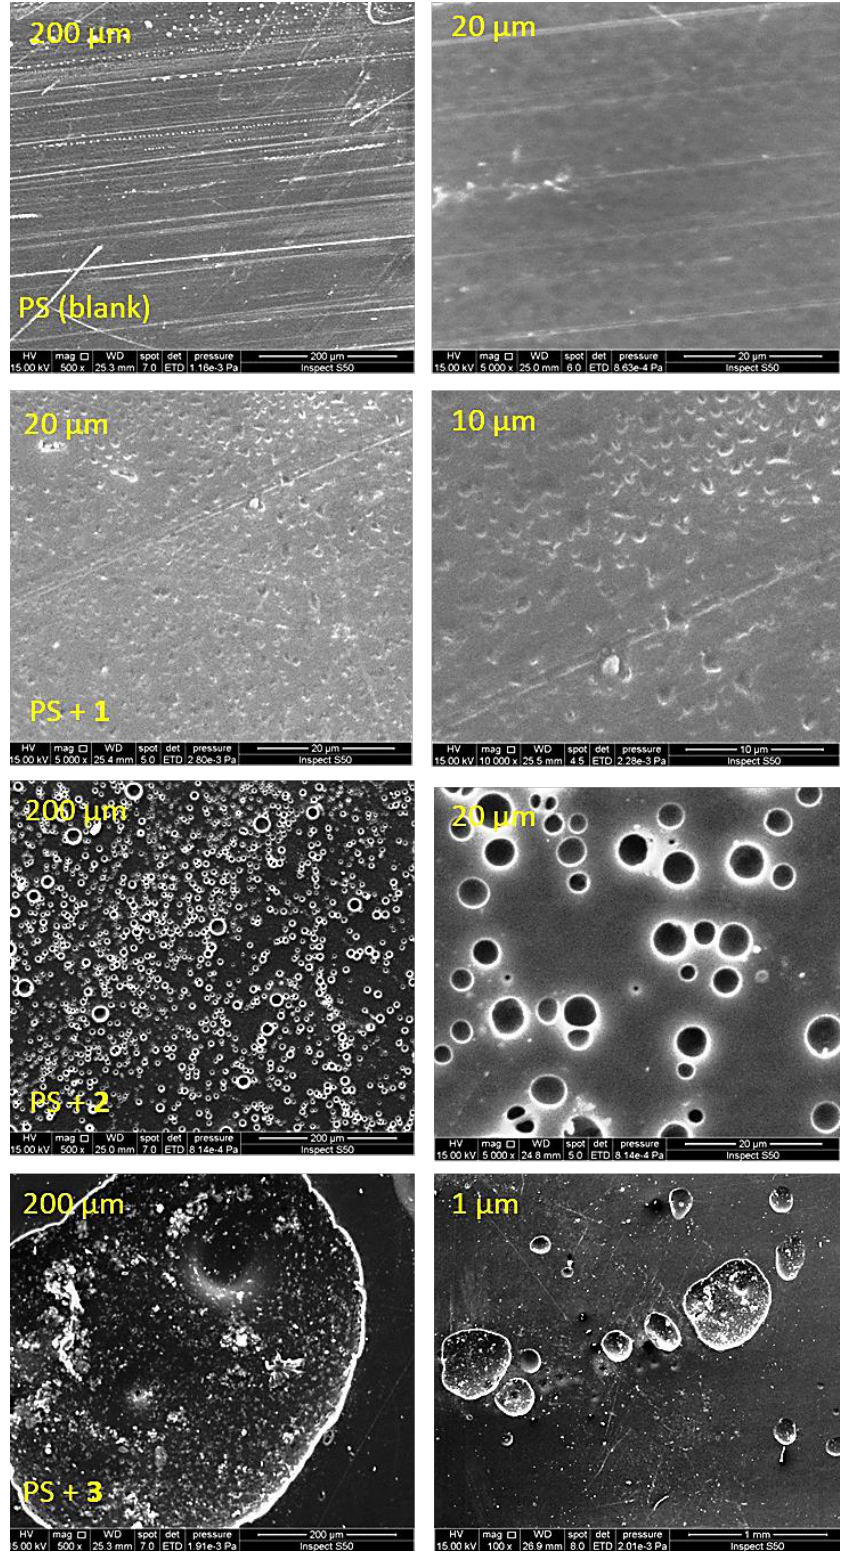
Figure 12. SEM images of PS and PS/Schiff bases 1 – 3 blends after irradiation.